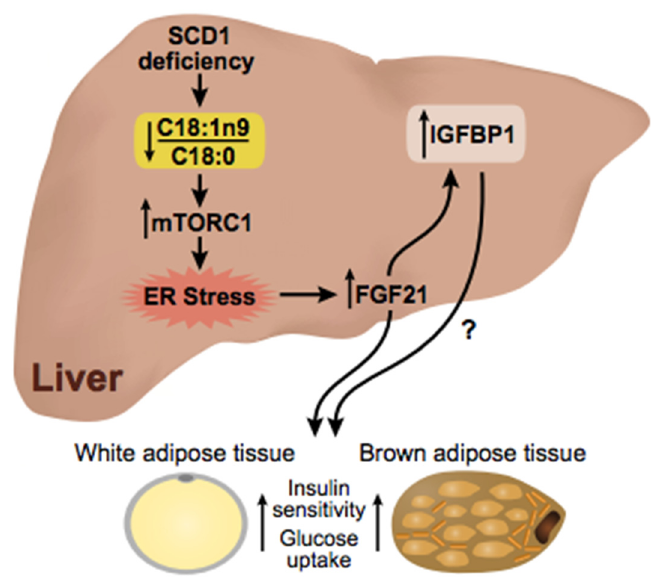
Figure 5. Proposed model of IGFBP1 induction through the mTORC1-FGF21